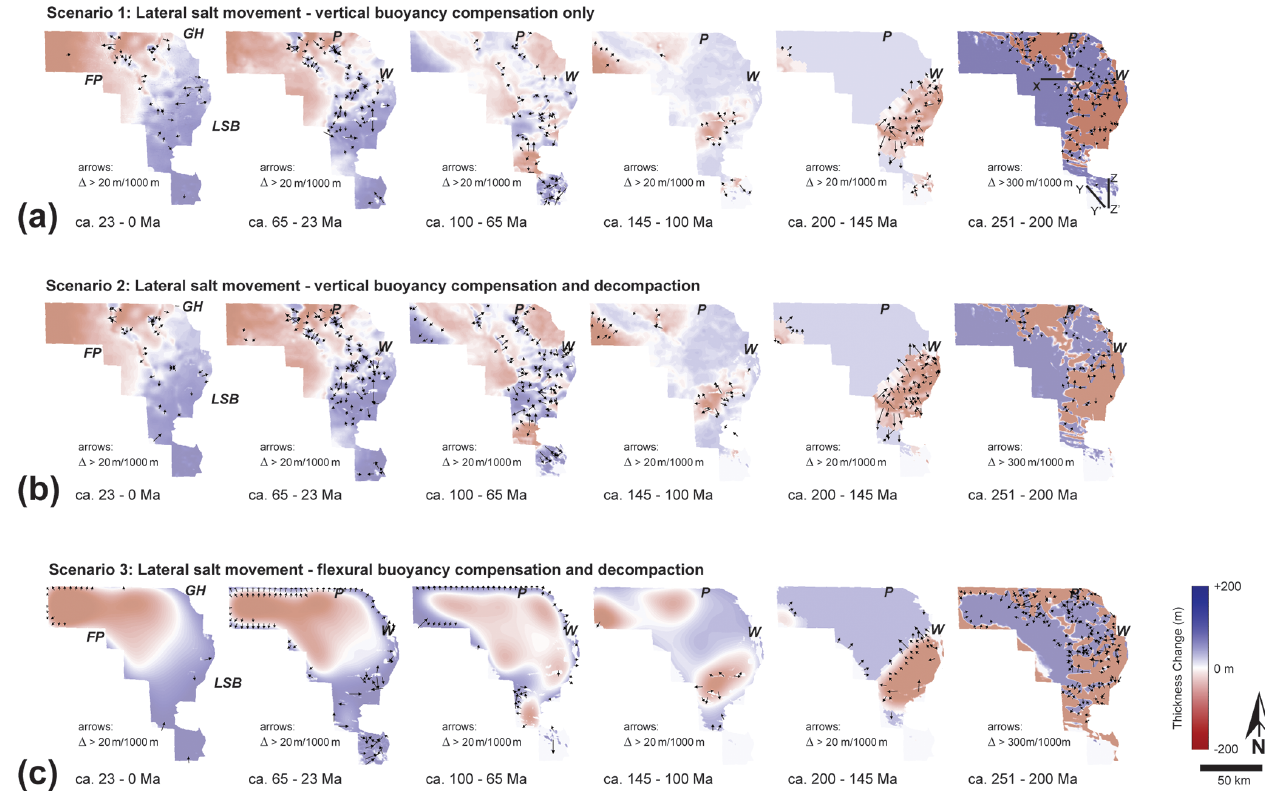
Figure 8. Maximum lateral change derived from difference plots of Fig. 7. (a) Orientation of maximum lateral change based on backstripping scenario 1. (b) Orientation of maximum lateral change based on backstripping scenario. (c) Orientation of maximum lateral change based on backstripping scenario 3. Note pronounced edge effects at northern boundary of study area associated with flexural backstripping (scenario 3). Two-dimensional restoration (scenario 2) extracted along sections X – X (cid:48) and Z – Z (cid:48) (see a , 251Ma) shown in Fig. 5.